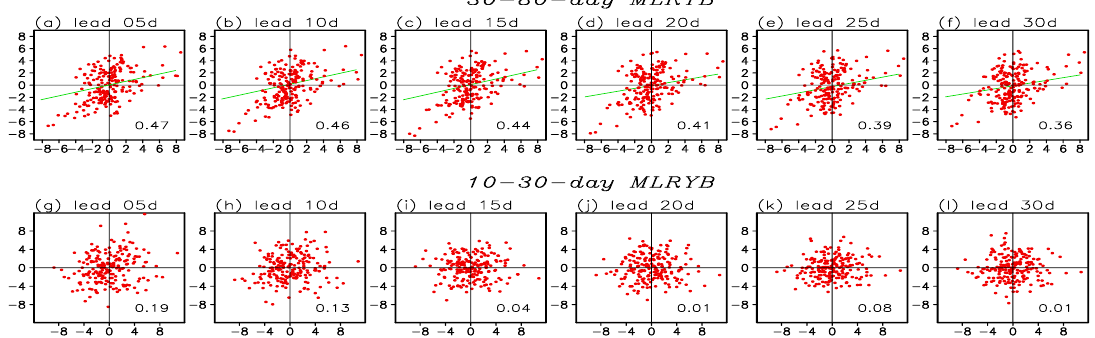
Figure 5. ( a – f ) Scatter plot for the observed ( x -axis, unit: mm day − 1 ) and 5–30-day lead forecasted ( y -axis, unit: mm day − 1 ) 30–80-day MLRYB rainfall index for the period 2003–2010. Green lines are the regression best fit lines, the correlation coefficients between forecasted and observed rainfall anomalies are shown in the bottom-right of each panel. ( g – l ) as in ( a – f ) but for the 10–30-day MLRYB rainfall index, the regression best fit lines in these panels are not shown.